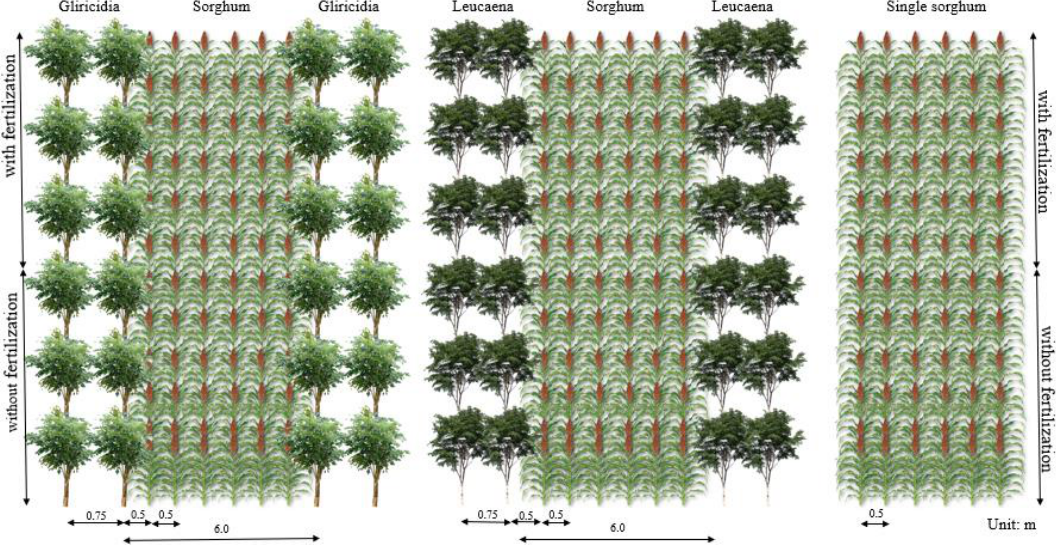
Figure 2. Scheme of the arrangement of cultivation systems and mineral fertilization in the experiment.